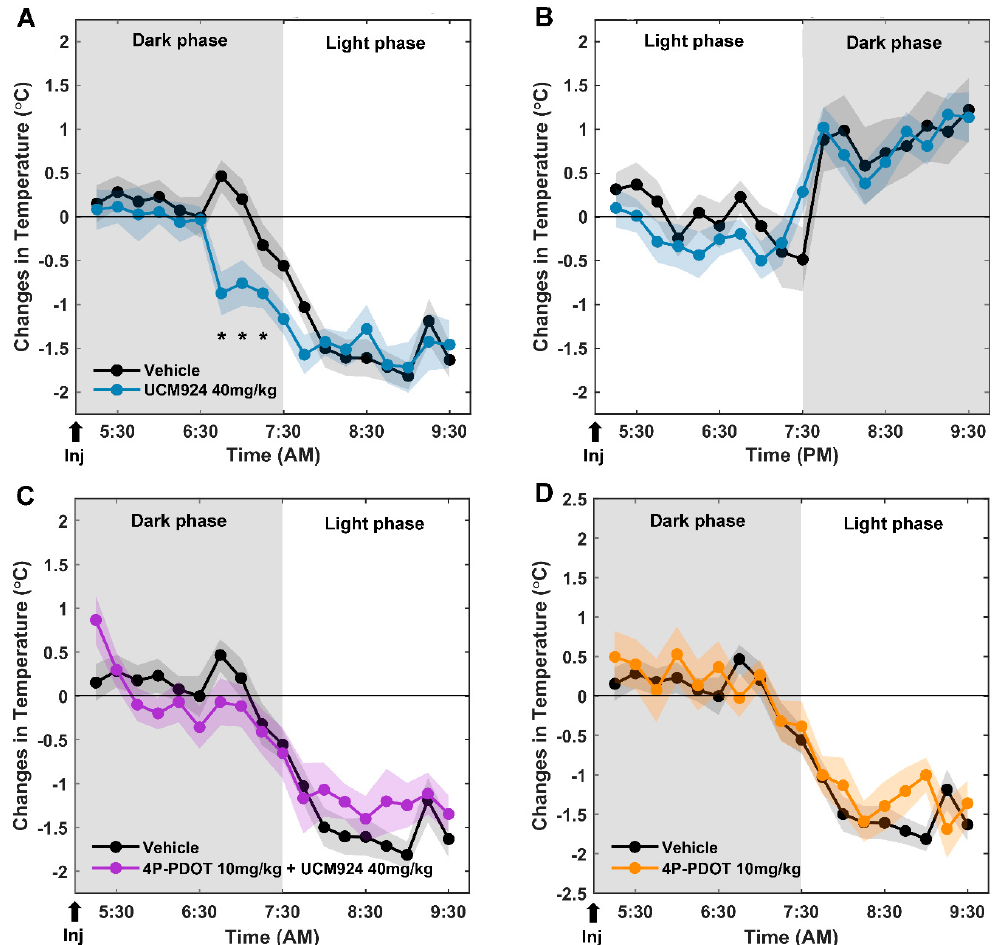
Figure 3. Changes in T b after UCM924 (40 mg/kg, s.c.) treatment during the light and the dark phase. ( A ) UCM924 (40 mg/kg) administered at 5:00 a.m. (light phase) decreases T b prior the light–dark shift compared with vehicle. ( B ) UCM924 (40 mg/kg) administered at 5:00 p.m. does not produce any change in the T b compared with vehicle. ( C ) 4P-PDOT pre-treatment blocks the effect of UCM924 on T b during the dark phase. ( D ) 4P-PDOT (10 mg/kg) injected during the dark phase does not affect T b . Data are expressed as mean ± SEM (graded shades). Lights on at 7:30 a.m. and off at 7:30 p.m. * p < 0.05 versus vehicle; two-way ANOVA for repeated measures followed by Bonferroni post hoc test. Inj: s.c. injection of either vehicle, UCM924, UCM924 + 4P-PDOT, or